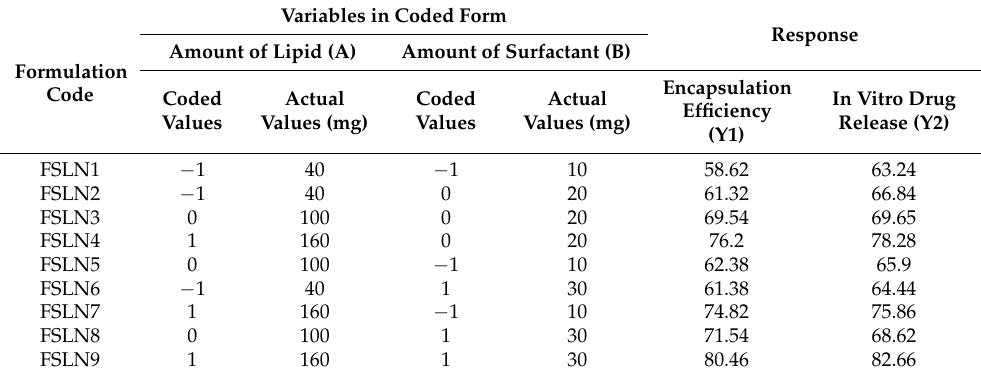
Table 1. Design layout of all formulations by 3 2 factorial